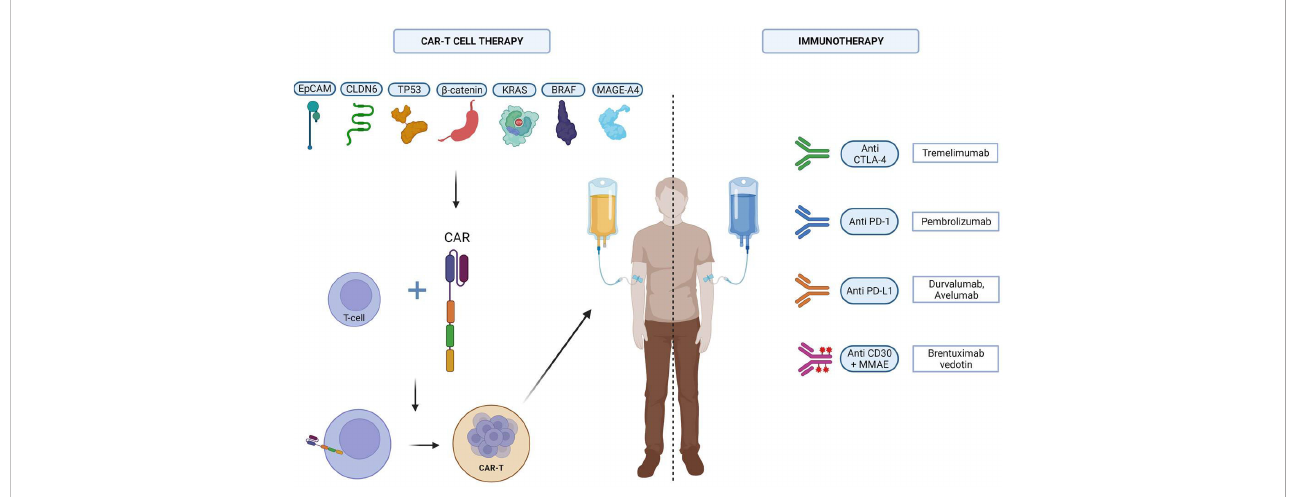
FIGURE 1 The different immunotherapeutic strategies tested against GCTs. Created with